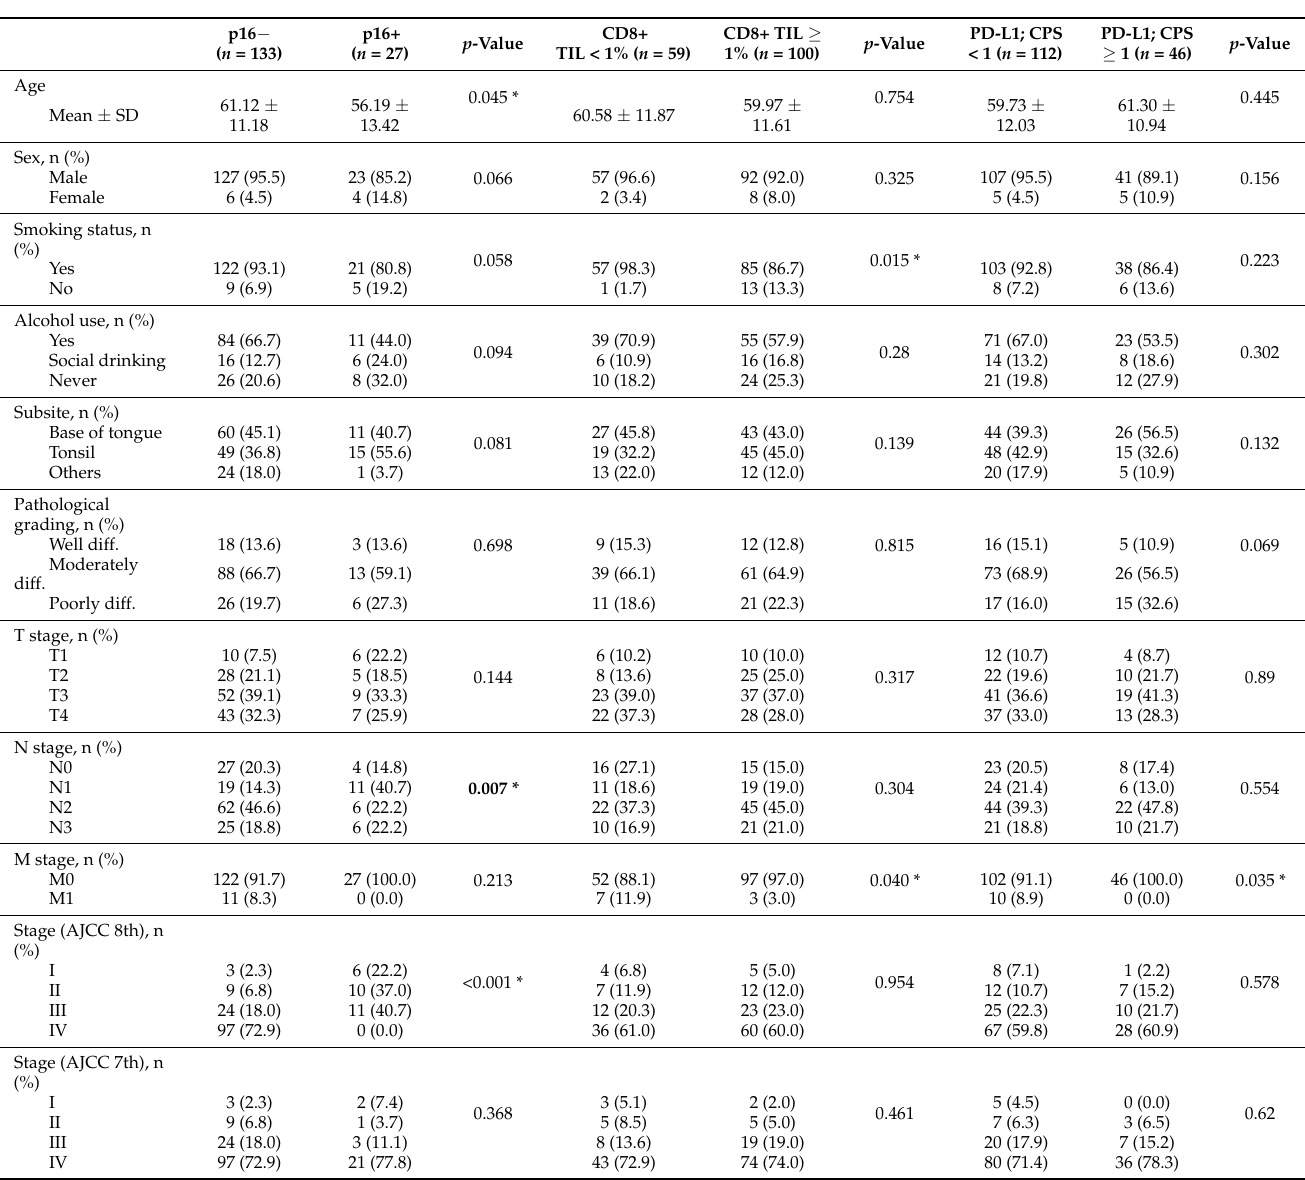
Table 3. Relationships between patient characteristics and